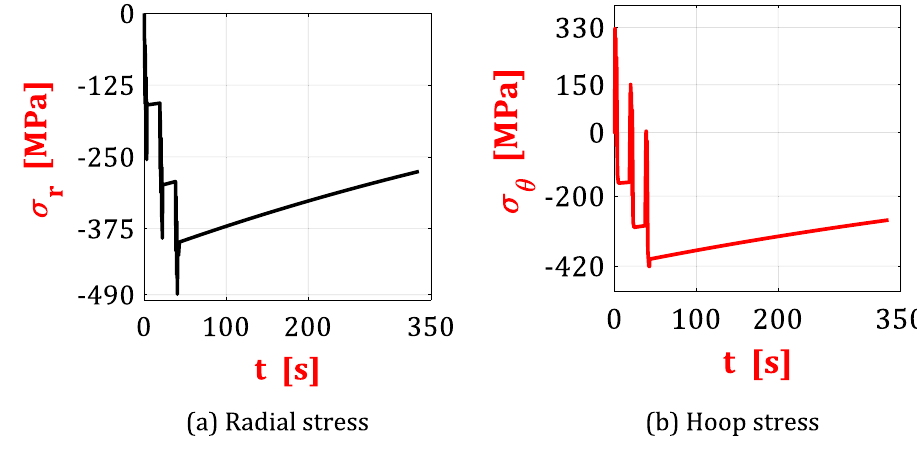
Fig. 20 Stresses-time history at the mid-radial section of the temperature-dependent barrel cylinder due to 85 thermo- mechanical shock